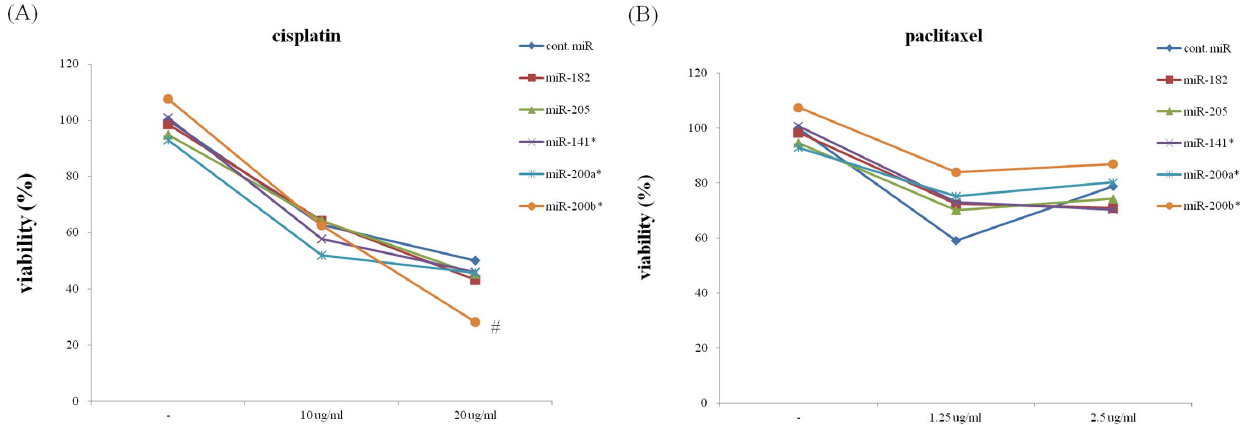
Figure 6. Effects of specific anti-miRs for the five miRNAss on the IC50 of cisplatin (A) and paclitaxel (B) in Hec1A cells. foot note: # anti-miR200b* slightly decreased total cell count with marginal significance in cisplatin treatment. p =0.07 vs. negative control ( n =3 experiments), the other four did not show significant difference compared with the negative control inhibitor.